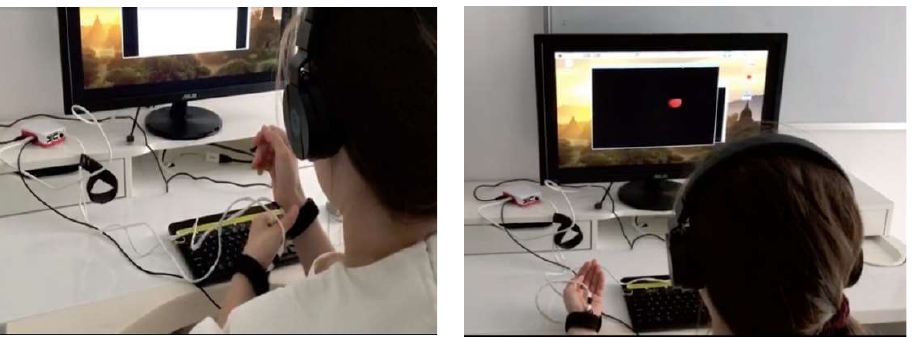
Figure 5. The participant is prepared for intervention. On the left side of the figure, we see how the user is fixing the actuators, while on the right side of the figure we see how the user is participating in an EMDR session.